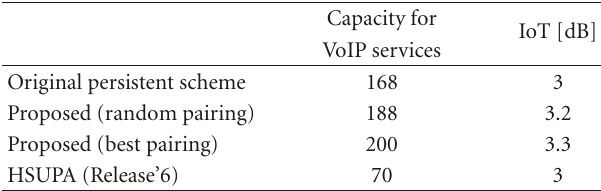
Table 3: Summary of VoIP capacity using proposed scheduling